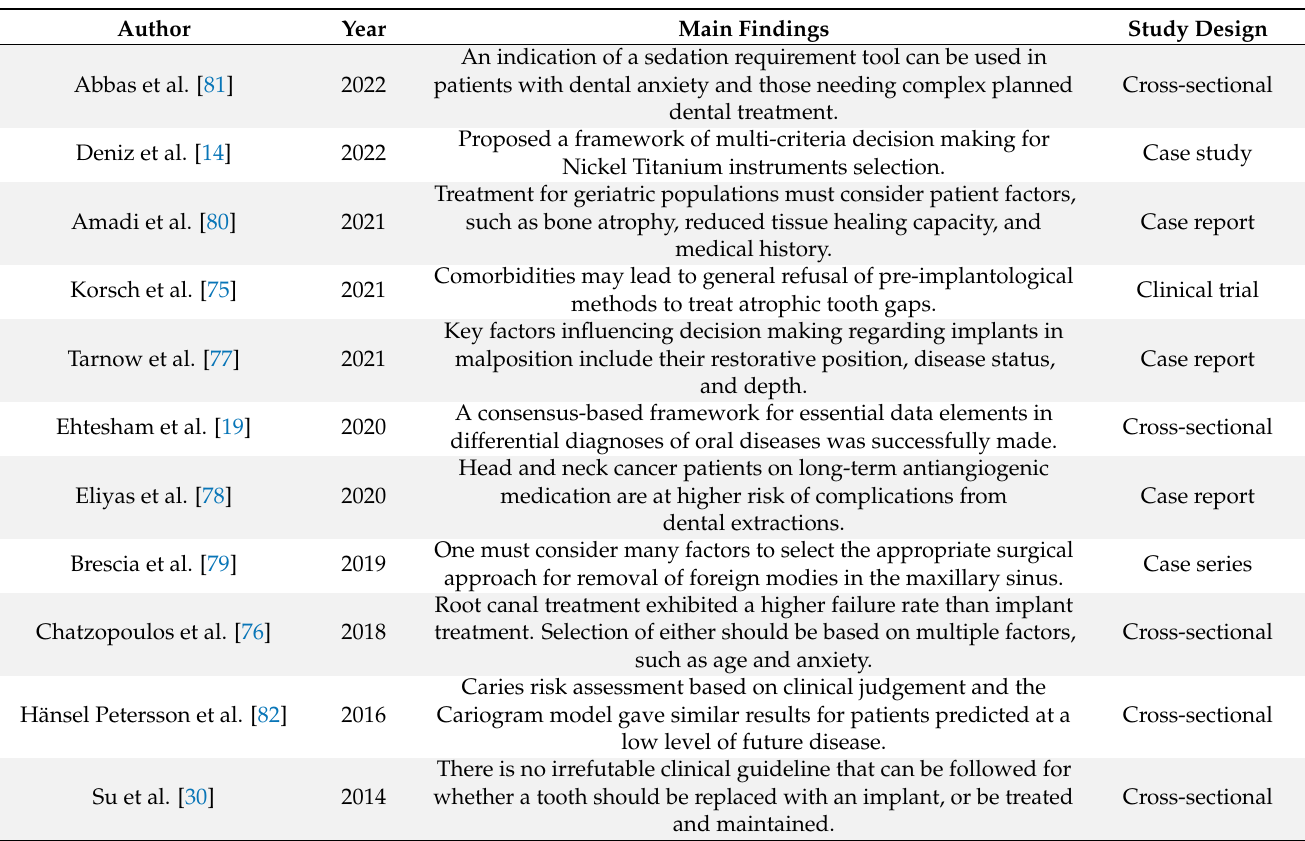
Table 6. Extracted articles that investigated the use of existing guidelines in clinical decision making under